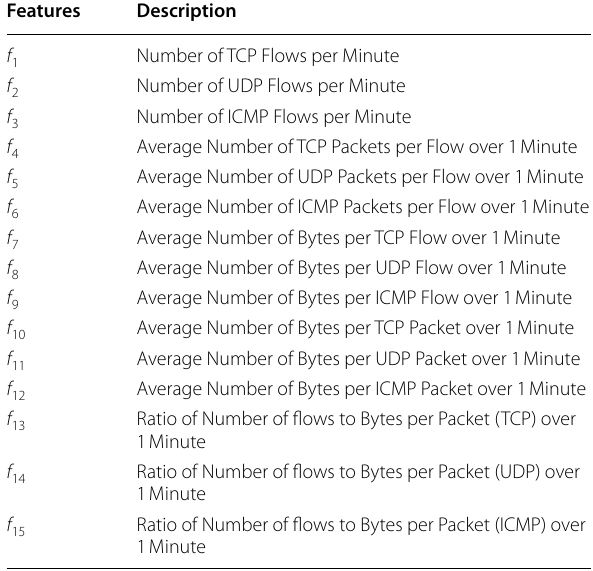
Table 3 Feature set collected at DP switches